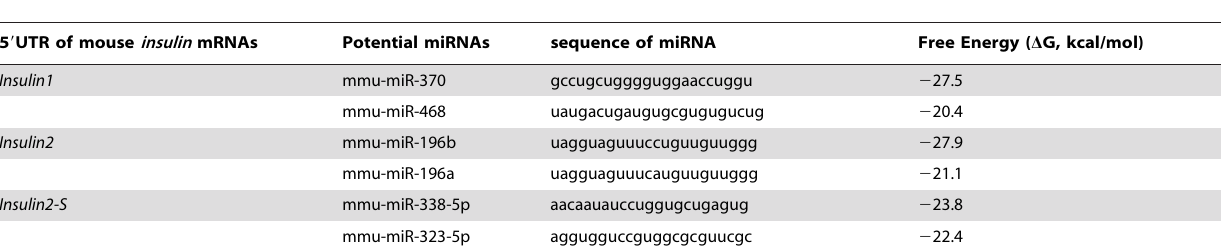
Table 1. miRNAs with potential target sites in the 5 9 UTR of mouse insulin mRNA and its binding energy to